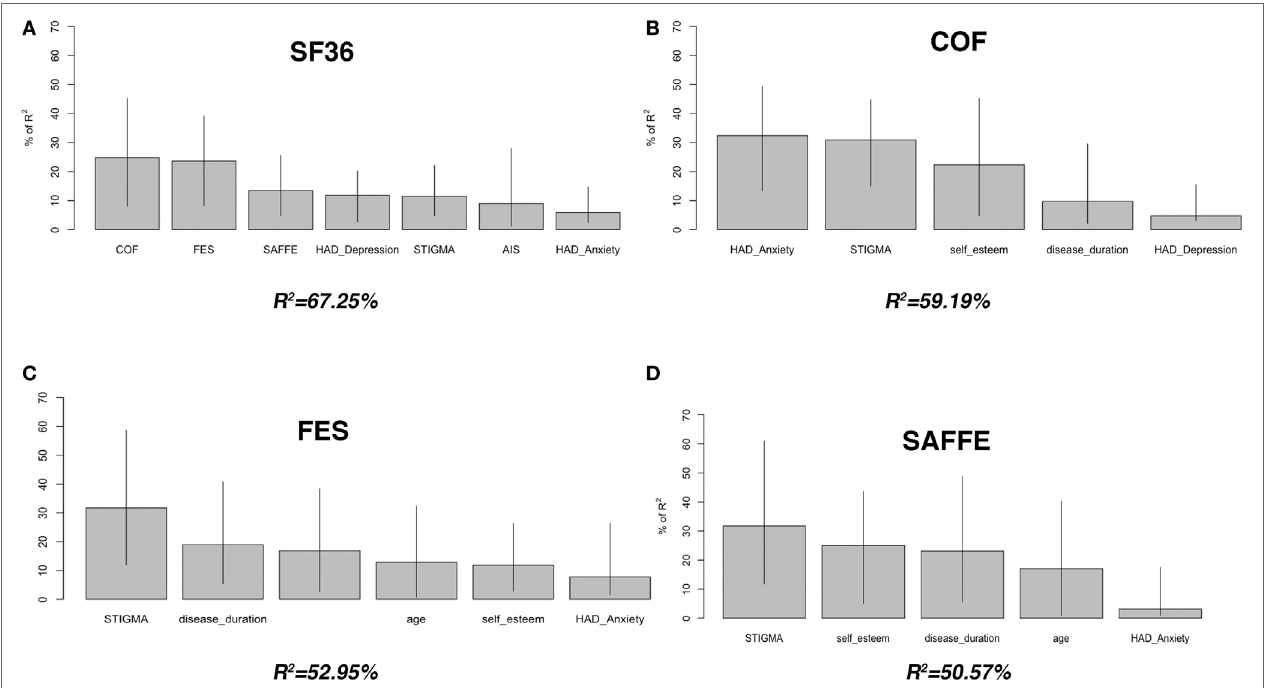
FigUre 2 | Contributors of health-related quality of life and fear of falling in patients with primary orthostatic tremor. We used Lindeman, Merenda and Gold (LMG) R 2 to estimate the relative importance of each regressor based on variance decomposition of variables included in the final models. The barplots show the proportion of variance in the response variable explained by each explanatory variable, with bootstrapped 95% confidence intervals. The scores were derived from the overall significant F -test in a one-way analysis of variance, i.e., F (7, 31) = 9.096, p < 0.0001, R 2 = 67.25 (a) , F (5, 33) = 9.57, p < 0.0001, R 2 = 59.19 (B) , F (6, 32) = 6.00, p < 0.0001, R 2 = 52.95 (c) , and F (5, 33) = 6.78, p < 0.0001, R 2 = 50.57 (D) . SF-36, short-form (36) health survey; COF, concern of falling scale; FES, falls efficacy scale; SAFFE, survey of activities and fear of falling in the